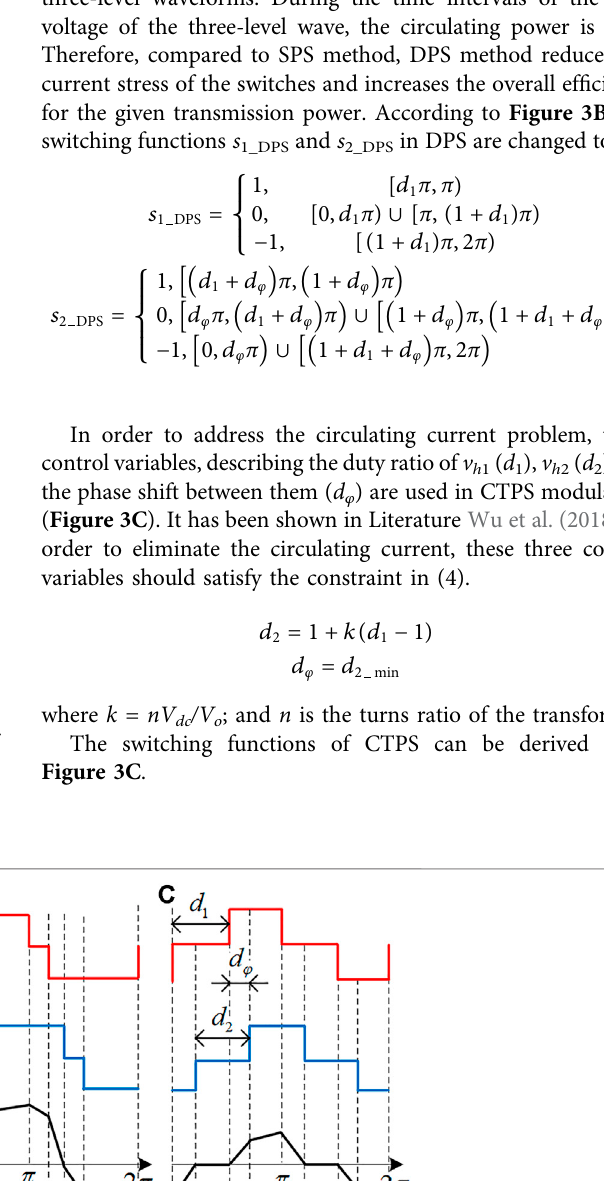
Frontiers in Energy Research |